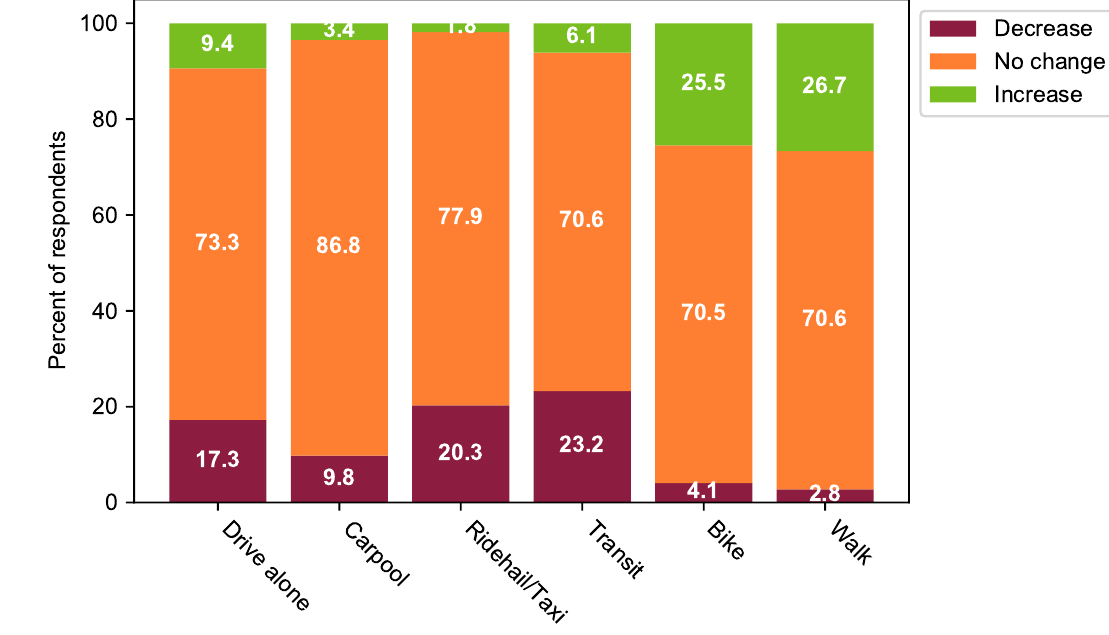
Figure 4. Expected change in mode usage ( n =